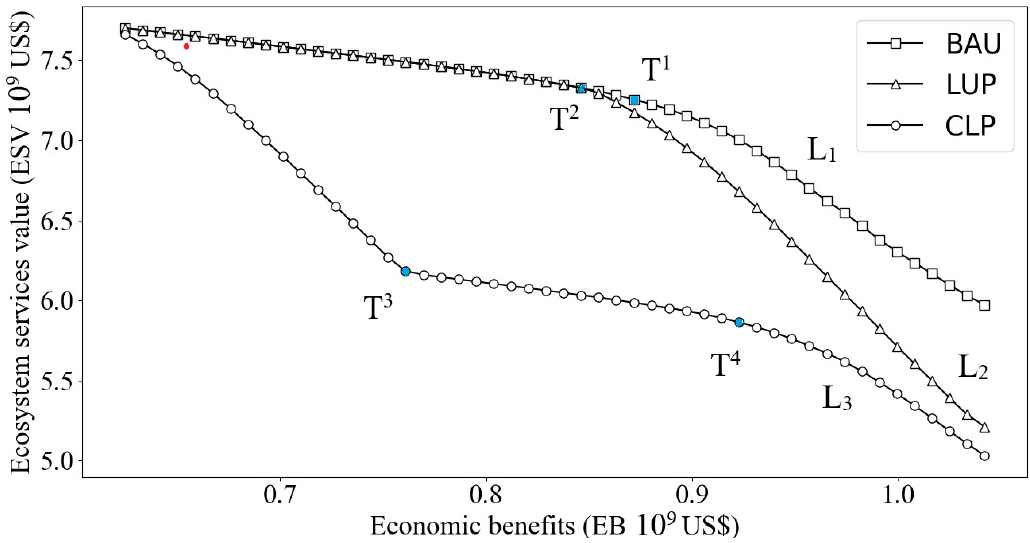
Figure 4. The relationship between economic benefits and ecosystem services value in the scenarios of business as usual (BAU, L 1 ), land use planning (LUP, L 2 ), and cropland protection (CLP, L 3 ). T 1 is the turning point in the BAU scenario. T 2 is the turning point in the LUP scenario. T 3 and T 4 are the turning points in the CLP scenario. The red point is the relationship between the economic benefits and ecosystem services value in Wuhan, 2015.